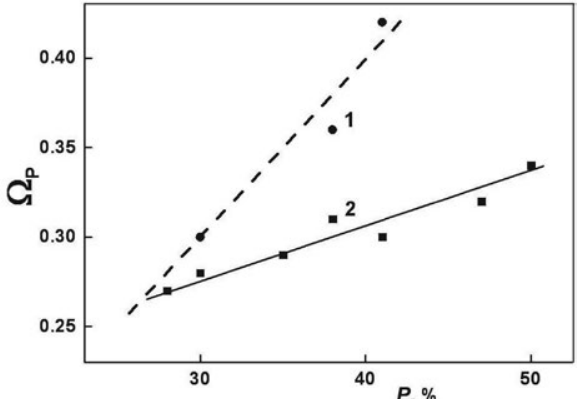
Figure 6. The dependences of the average lattice density Ω phase clusters on the surface of PE (1) and PP (2) films on overall porosity P. The dashed line corresponds to Ω